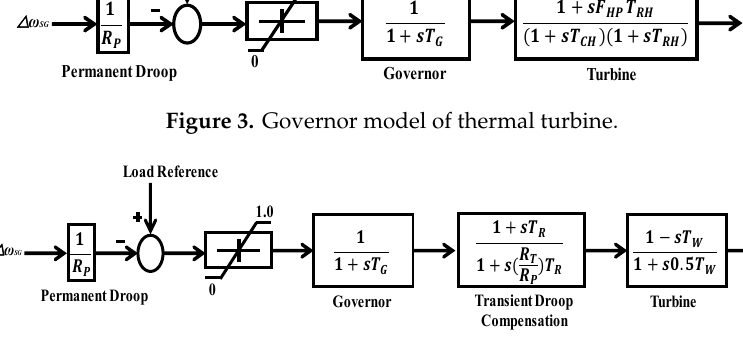
Figure 3. Governor model of thermal turbine.